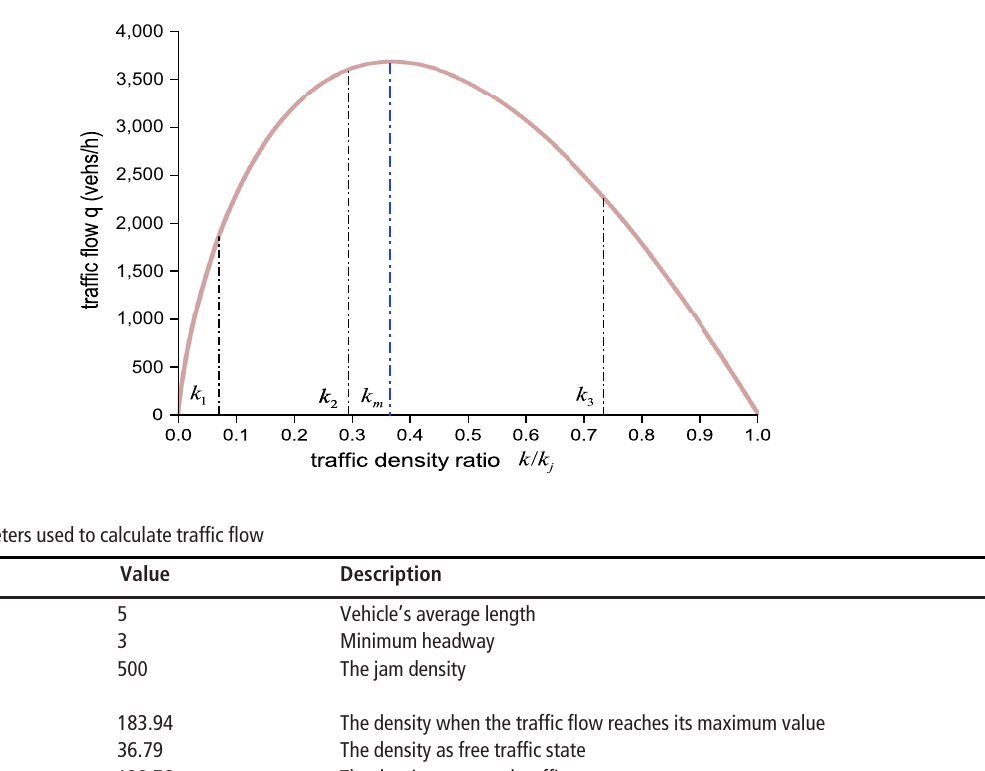
Figure 3 Traf fi c fl ow versus traf fi c density